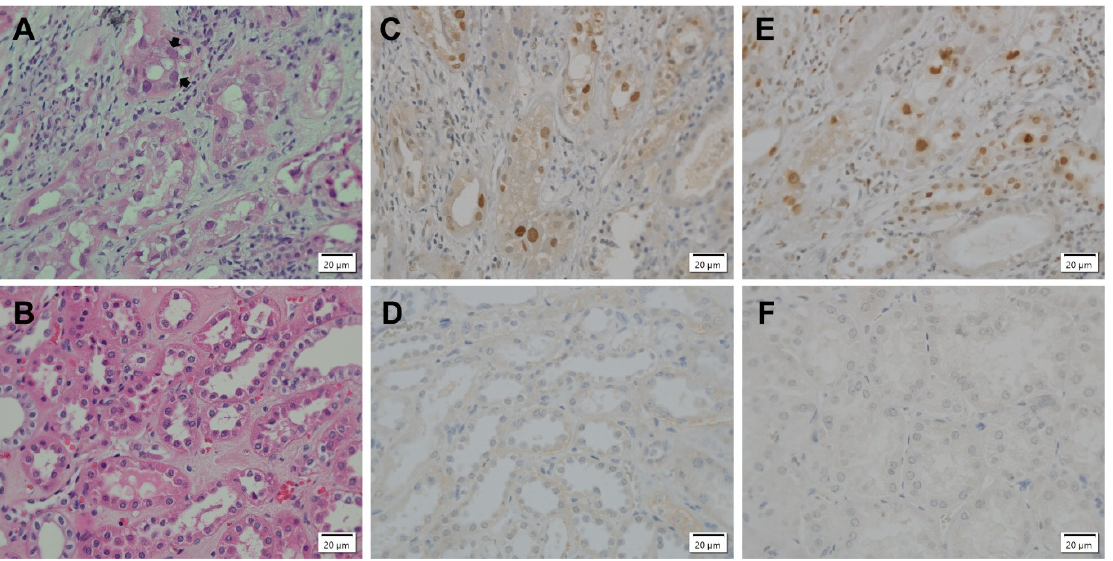
Figure 1. IHC detection of a DNA damage response in PyVAN. Formalin-fixed, paraffin-embedded PyVAN biopsy, stage B2 ( A , C , E ) and normal kidney ( B , D , F ). ( A ) Interstitial inflammation with edema and fibrosis. Marked viral activation with tubular epithelial cell lysis and associated denudation of tubular basement membranes. Arrows indicate amorphous, ground glass polyomavirus inclusion bodies (H&E stain). ( B ) Normal kidney (H&E stain). ( C ) IHC detection of intranuclear polyomavirus TAg in tubular epithelial cells. Positive nuclei contain brown diaminobenzadine reaction product (PAb 416, anti-SV40 TAg primary antibody). ( D ) Normal kidney stained for TAg, as in C. ( E ) IHC detection of DDR marker γ H2AX (anti pH2AX-Ser139 primary antibody) in nuclei of tubular epithelial cells. ( F ) IHC normal kidney stained for γ H2AX as in E. (40X objective).